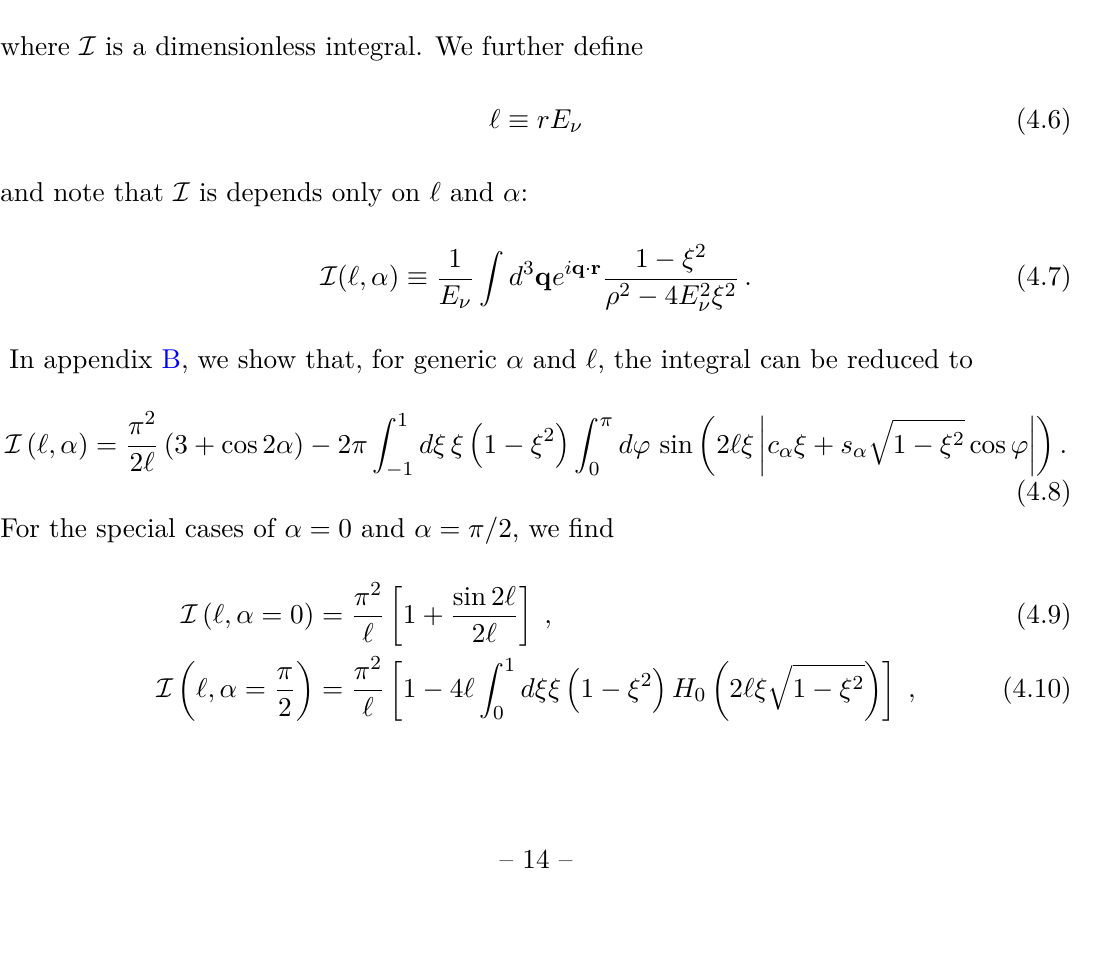
. In addition, an overall dimensionless factor, G 2 ν